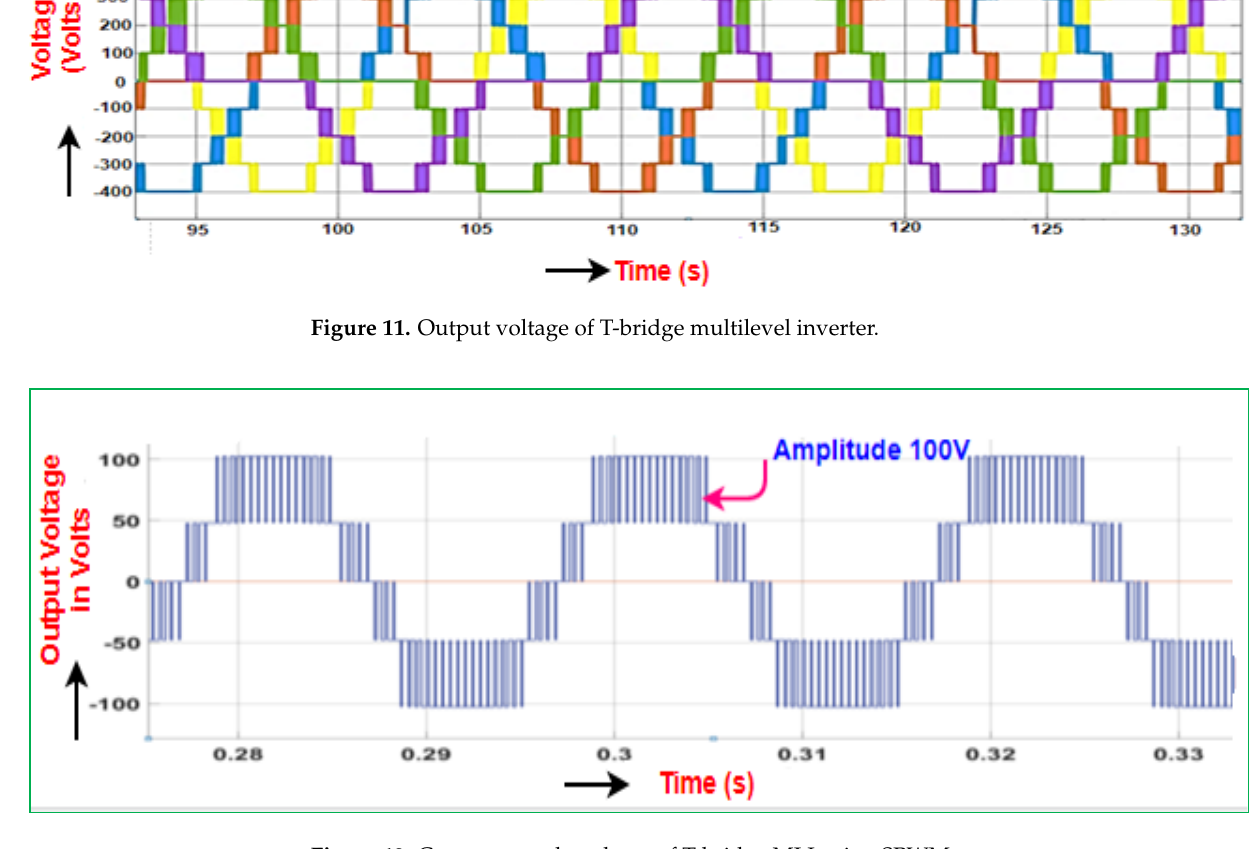
Figure 12. Common mode voltage of T ‐ bridge MLI using SPWM.